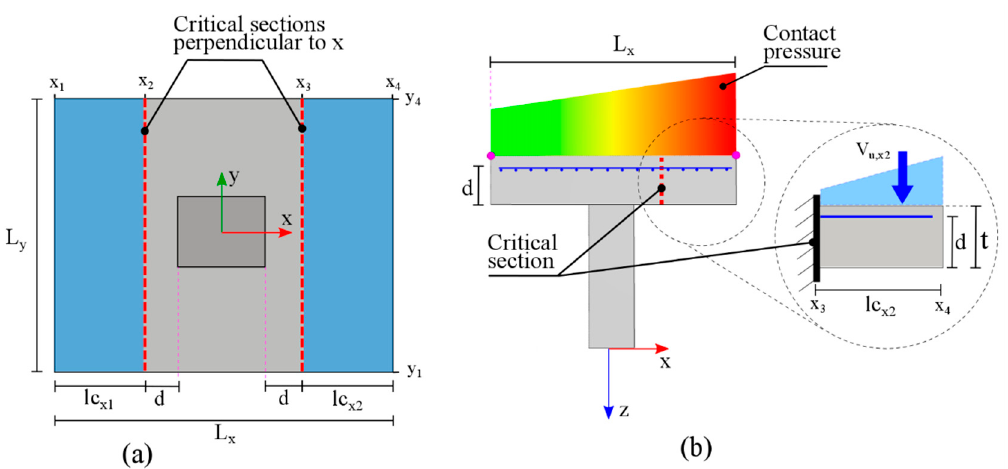
Figure 4. Critical sections for one-way shear (perpendicular to x direction): ( a ) plan view; ( b ) elevation view.